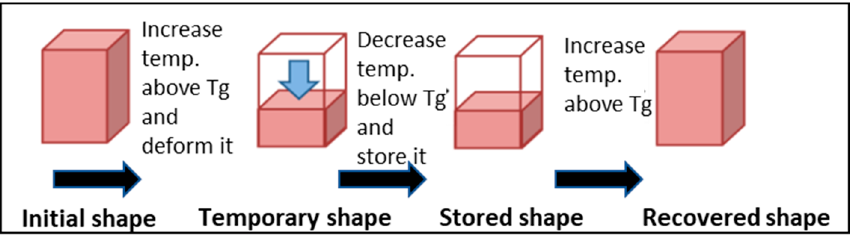
Figure 1. Shape memory effect steps in polymers.